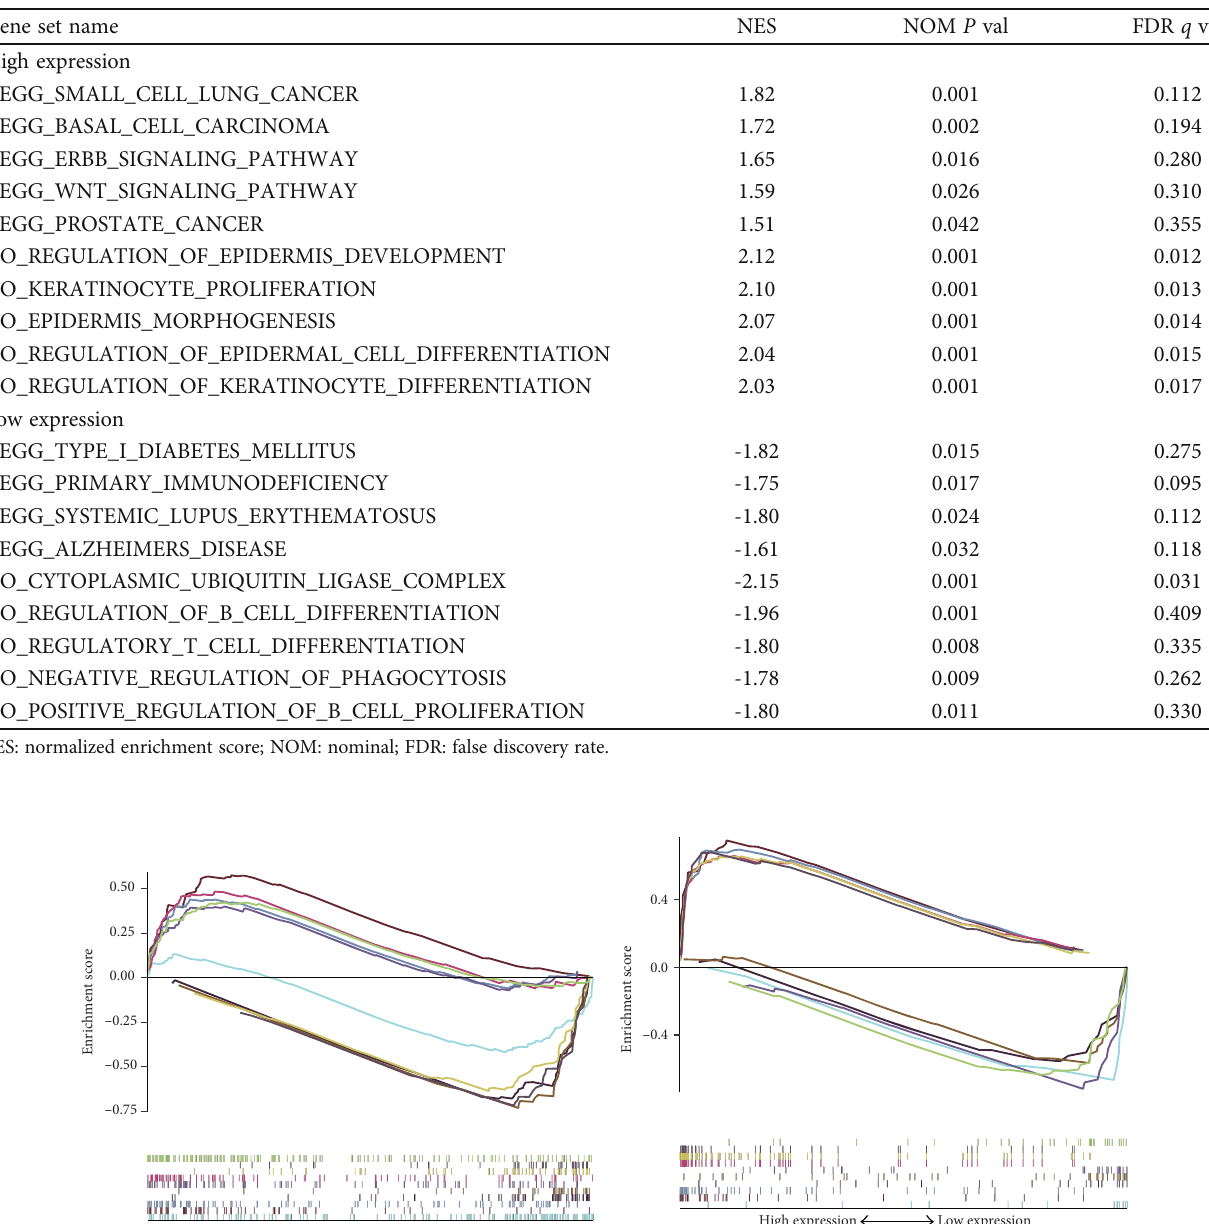
Table 2: Gene sets enriched in phenotype.